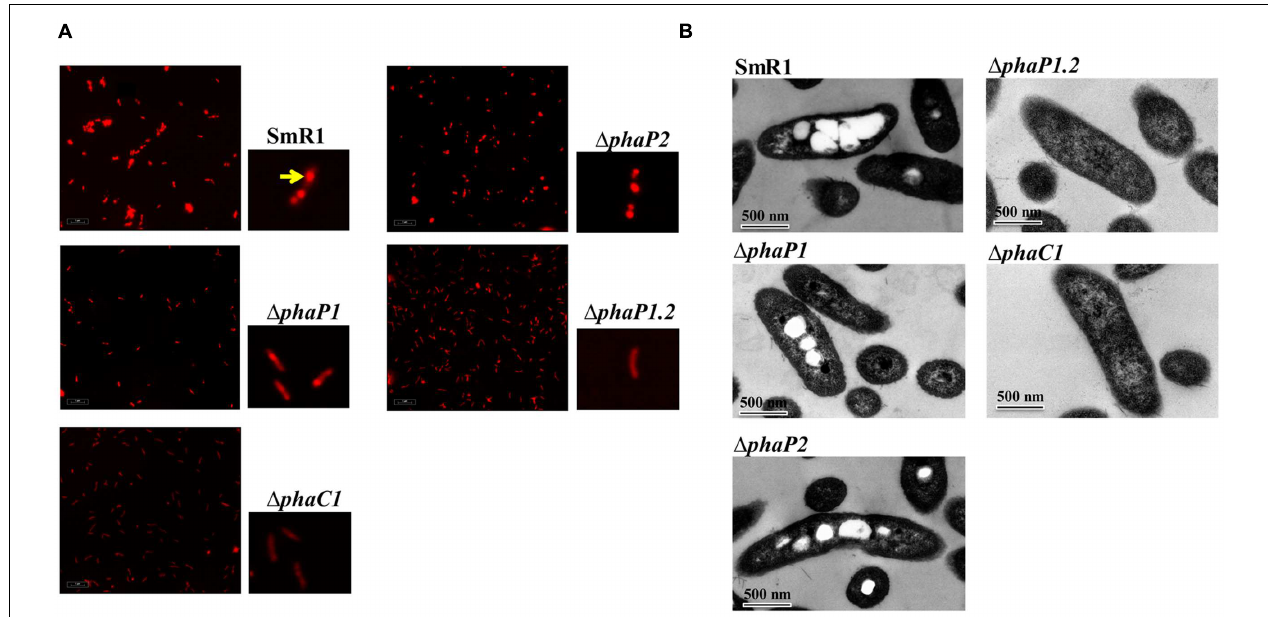
FIGURE 3 | Fluorescence microscopy and transmission electron microscopy of H. seropedicae SmR1, phaP and phaC1 mutants. (A) Strains were grown in NFb medium with 37 mM DL -malate and 20 mM NH 4 Cl to an OD 600 of 1.0. Cells were stained with Nile Red and visualized by excitation with 543 nm light. The yellow arrow in the SmR1 panel indicates a typical PHB granule stained with Nile Red. (B) The strains cultivated in NFb medium with 37 mM DL -malate and 20 mM NH 4 Cl to an OD 600 of 1.0 were processed and visualized by TEM. The black bar represents 500 nm in scale. TABLE 3 | Transcriptional analysis of P phaP1 - lacZ and P phaP2 - lacZ fusions in E. coli ET8000 expressing PhaR from H. seropedicae SmR1. β -galactosidase activity 2 h after Strain β -galactosidase activity before induction (Miller units) induction (Miller units) ET8000/pDK6/P phaP1 - lacZ 8,516.5 ± 693.3 11,801.3 ± 642.1 ET8000/pMMS31/P phaP1 - lacZ ∗ 168.0 ± 6.4 ∗∗ 89.7 ± 2.5 ∗∗ 11,180.8 ± 142.8 12,061.1 ±